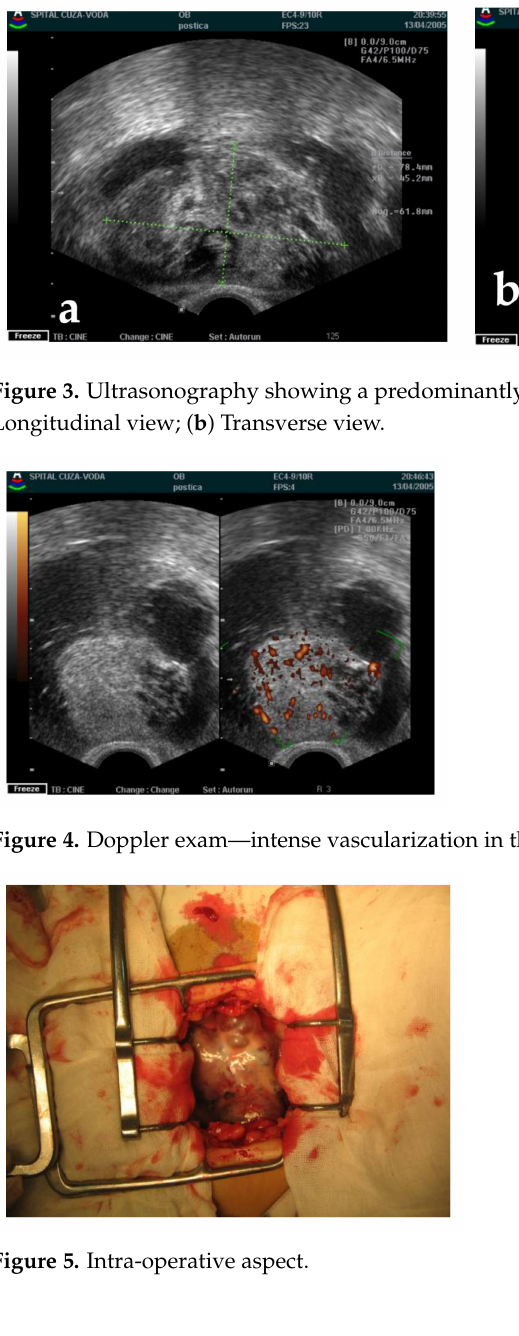
Figure 2. ( a ) Gross appearance of the ovarian tumor; ( b ) Longitudinal section of the ovarian mass showing a polycystic aspect.